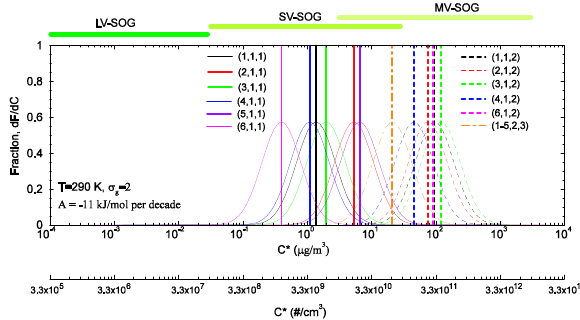
Figure 2. Fig. 2. Normalized distributions ( f SOG (C ∗ ) , with geometric stan- dard deviation σ g = 2) of SOG i,j,k at T = 290K. The vertical lines are the median C ∗ . Second x-axis of C ∗ in #/cm 3 is calculated from C ∗ inµg/m 3 based on molecular weight of 181g/mol. The numbers inside the parenthesis in the figure legend are ( i,j,k) of each prod- uct. See text for more